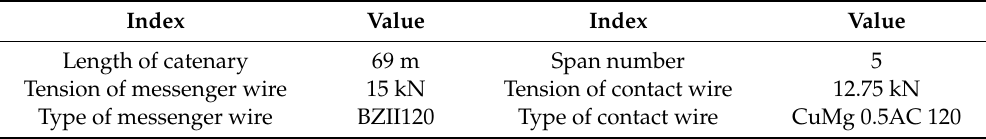
Table 3. The structural parameters of the catenary test